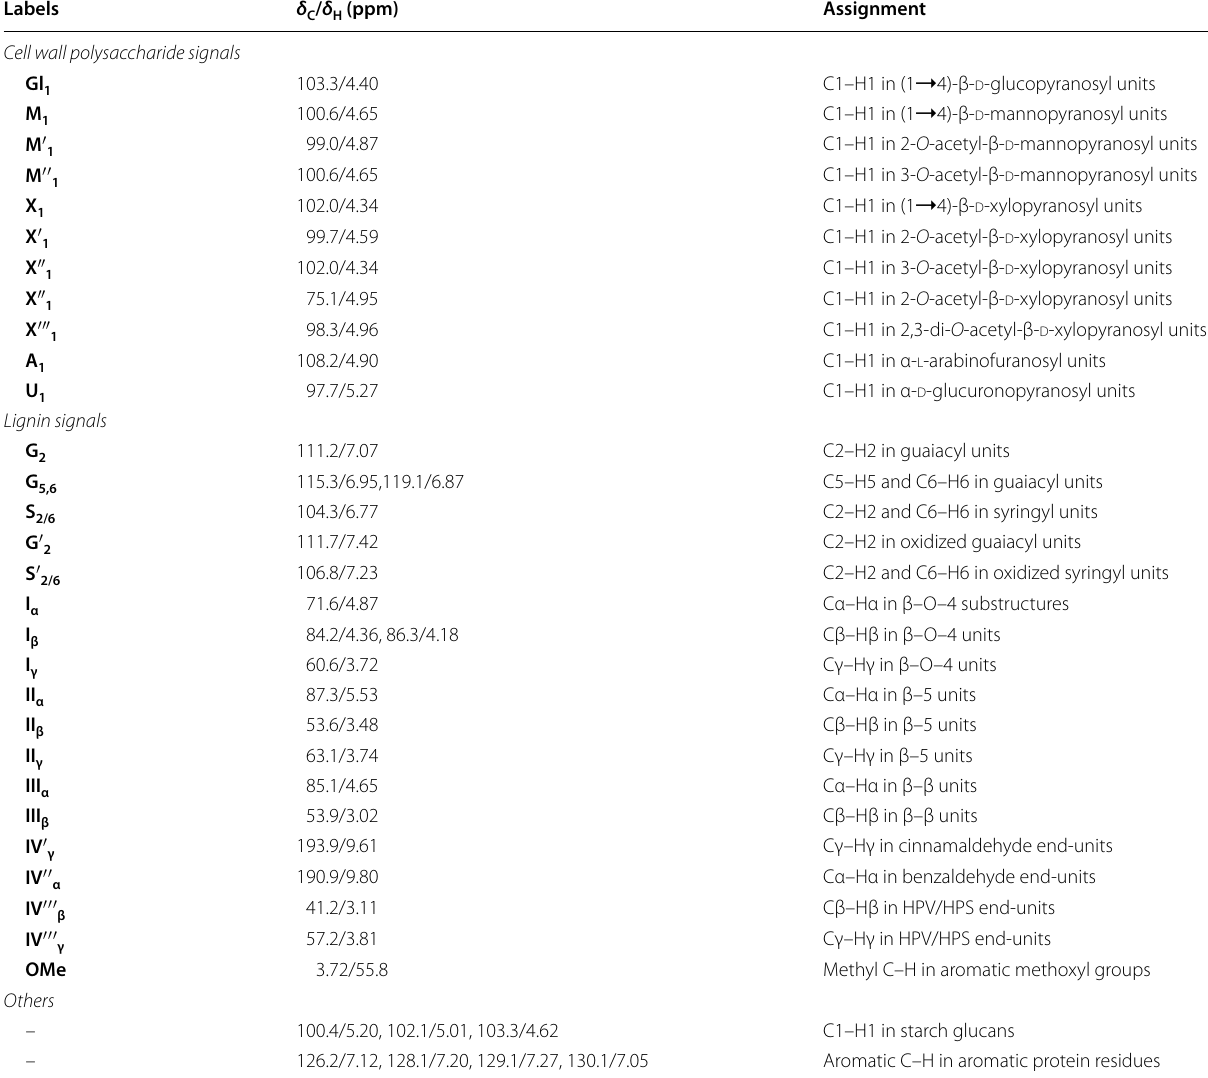
Table 2 Assignment of polysaccharide and lignin signals in 1 H– 13 C correlation (HSQC) spectra of pine and Shorea diet cell wall